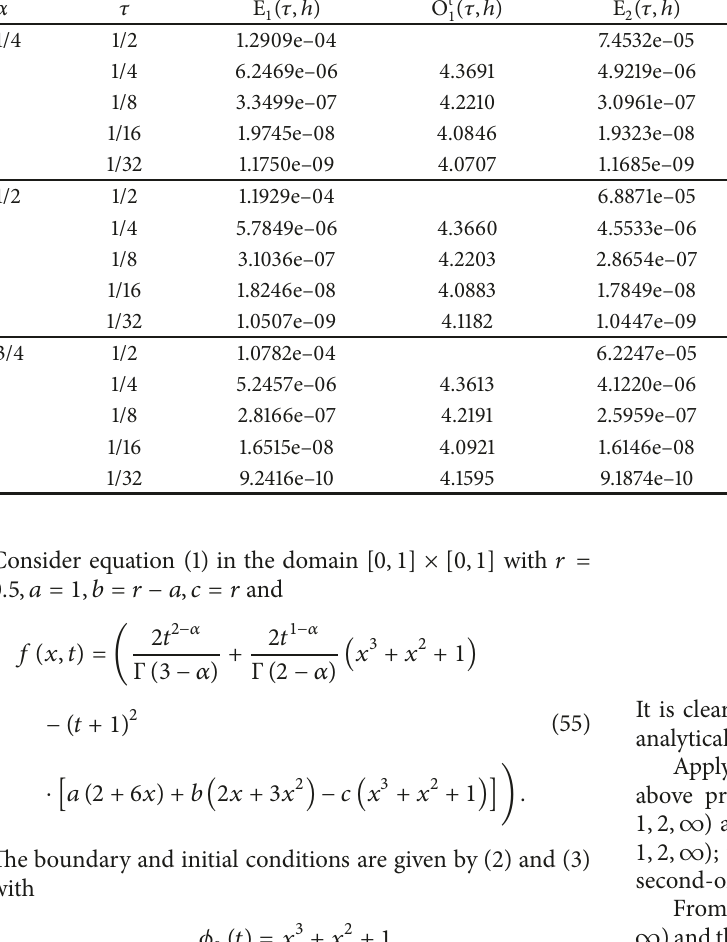
Table 4: The errors and the spatial convergence orders of the compact difference scheme (23) for Example 2 (ℎ = 1/15000) .